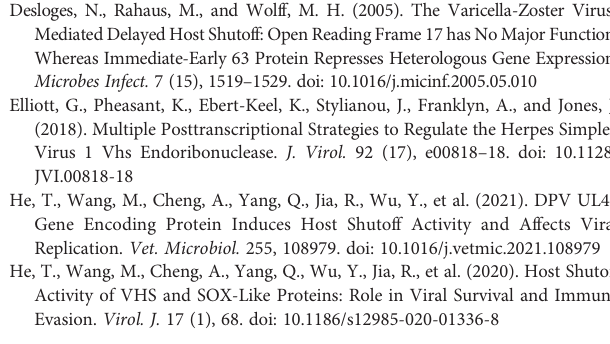
Supplementary Figure 1 | Thetransfection ef fi ciency of BL cellsand MDBK cells. (A) Direct fl uorescence analysis of the transfection ef fi ciency of BL and MDBK. A plasmid of pcDNA3.1-EGFP transfected into BL and MDBK cells by 2× Max transfection reagent, (B) Western blot analysis of the transfection ef fi ciency of BL and MDBK. Recombinant plasmids of pX330-sgRNA UL41 1-3 were transfected into BL and MDBK cells by Lipofectamine 3000 reagent (Invitrogen, USA). Cas9-Flag indicated the expression of recombinant plasmids, and GAPDH was the internal reference